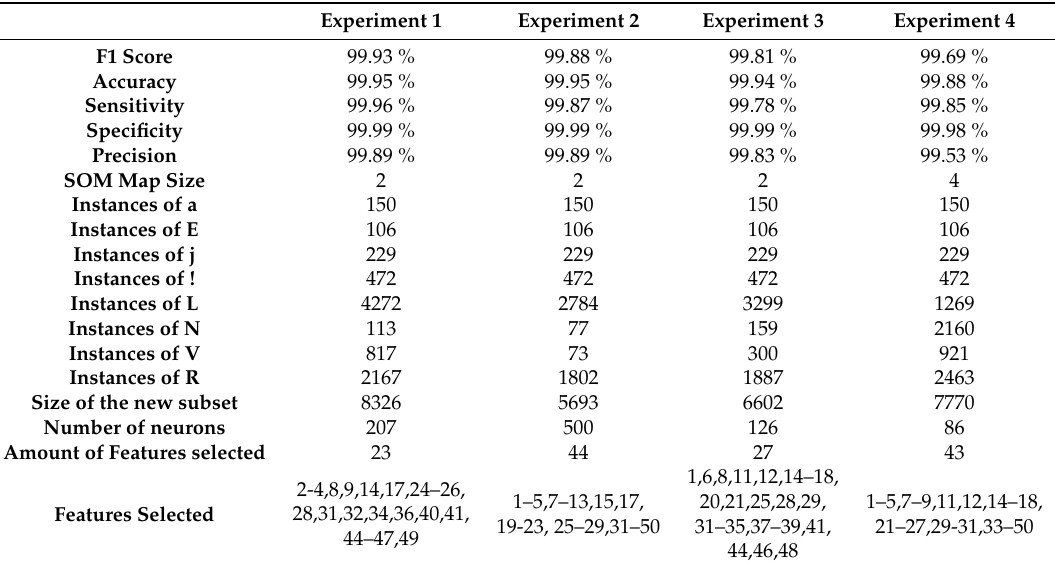
Table 7. Best solutions of the experiments on ten